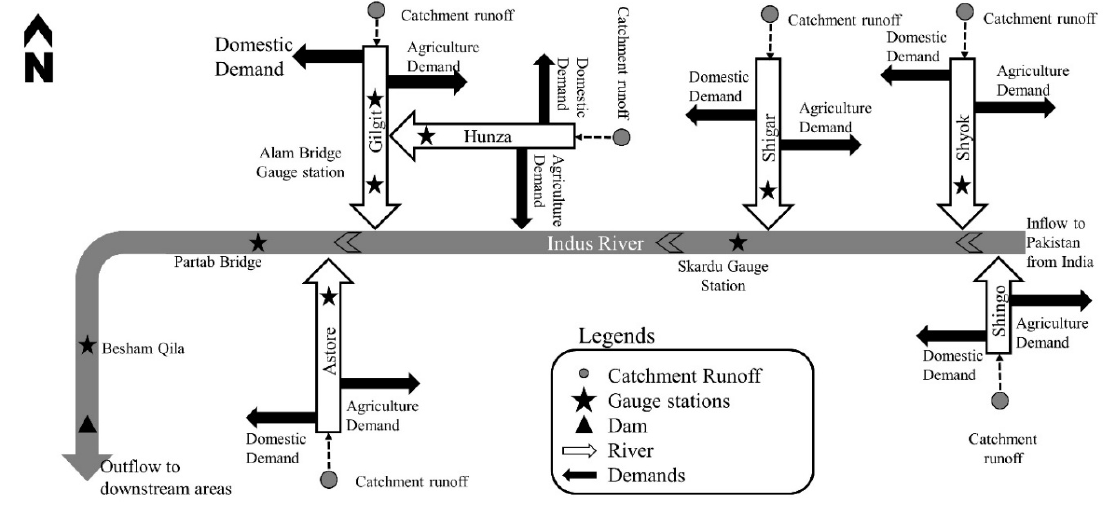
Figure 5. The structure of the water supply service in the catchment.